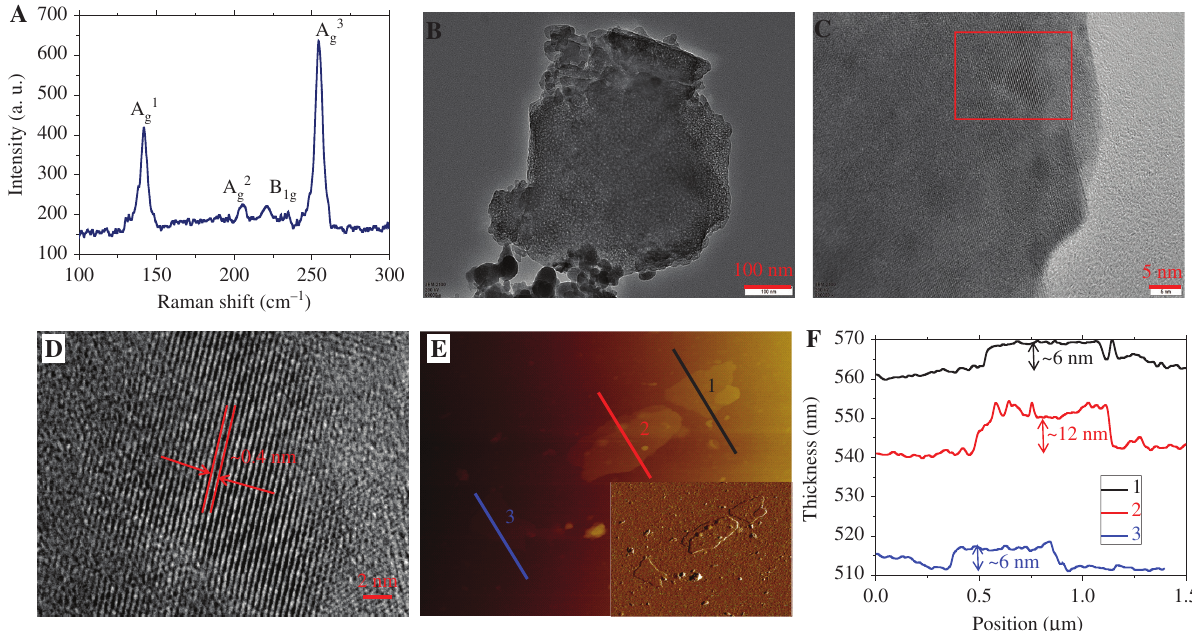
. 2 powder. (B) TEM image of the PdSe 2 nanosheets. (E) Inset: The corresponding morphology of the PdSe 2